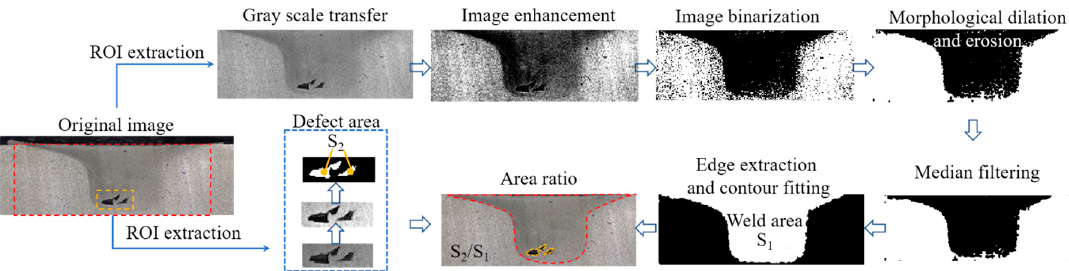
Figure 11. Calculation process of the area ratio of defects to the weld.